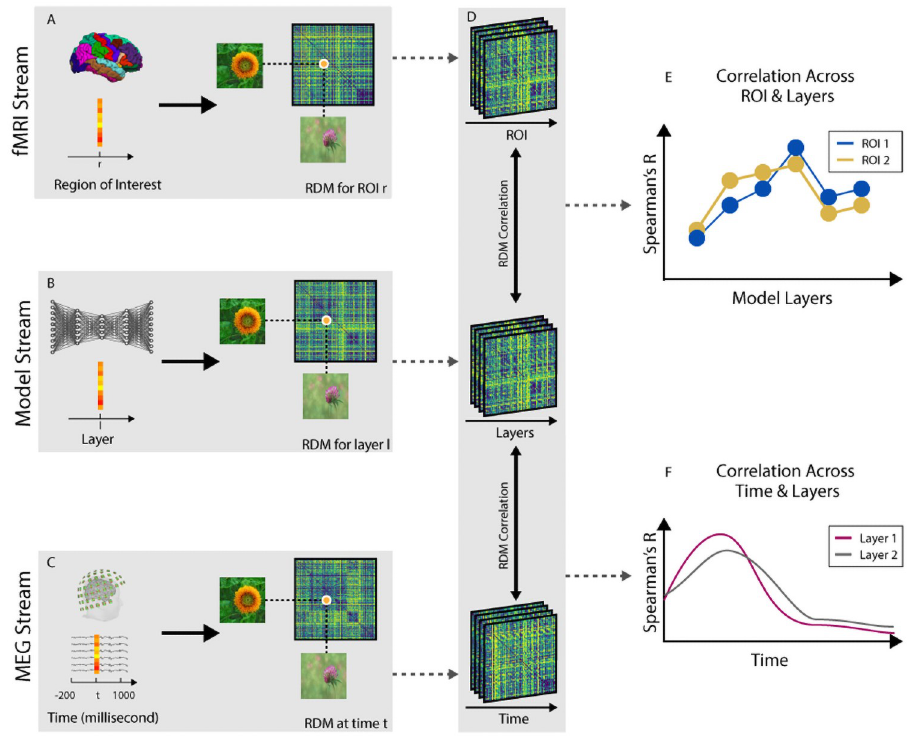
Fig 3. Representational similarity analysis to compare fMRI, MEG and model representations. (A) fMRI response patterns were extracted from each ROI and pairwise condition-specific dissimilarities (1-Pearson’s R) were computed to create one fMRI RDM per ROI and participant (see Materials and methods section for detail). (B) RDMs for the generative model were computed at each convolutional/deconvolutional block after feeding 156 images to the computational model. (C) MEG data consists of time-series data with 306 channels and 1200 time points (milliseconds) per trial. For each condition, we extracted a vector of size 306 at each time point as the whole brain activity pattern to compute the RDMs using SVM classifiers decoding accuracies (see Materials and methods section for detail). (D) Using RDMs from MEG and fMRI ROIs, we compared (Spearman’s R) them with the RDMs from the computational model to investigate the spatio-temporal correspondences between the human brain and the computational model. (E) Correlations between ROI fMRI RDMs and computational model RDMs result in a subject- specific correlation value for each ROI across model layers, which we then average them over subjects. (F) Correlations between time-resolved MEG RDMs and computational model RDMs result in a subject-specific signal for each layer across time, which we then average them over